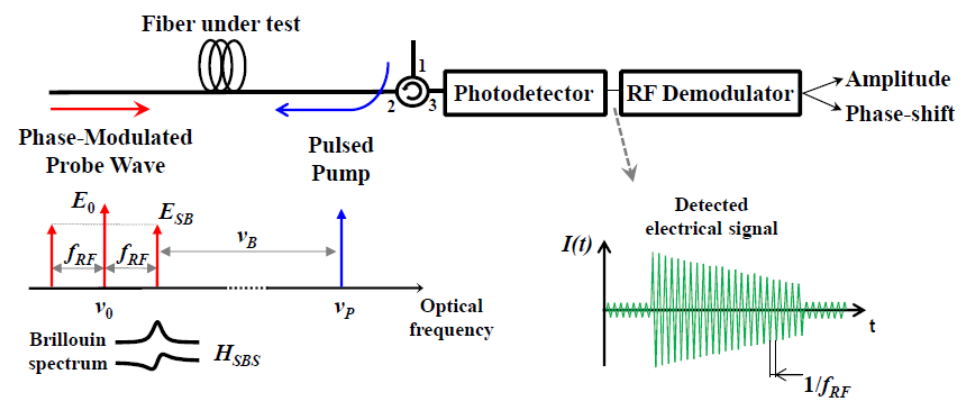
Figure 10. SBS interaction between a pulsed pump and a phase-modulated probe wave for dynamic strain measurements [47].